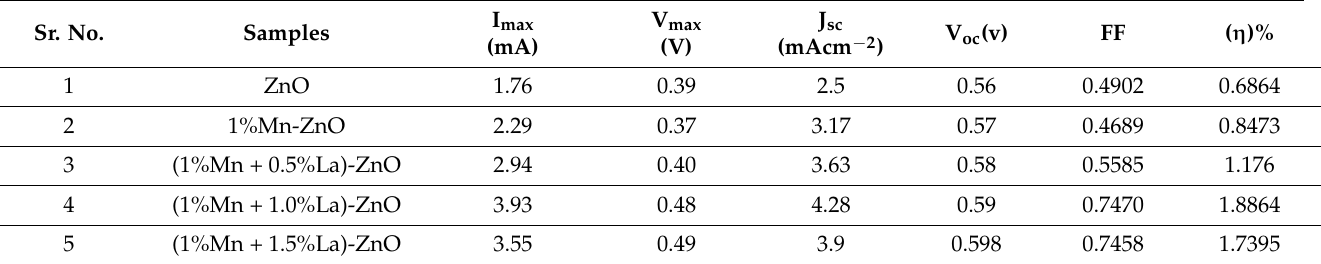
Figure 11. Current density–voltage curves for undoped and co-doped ZnO-based DSSCs. Table 3. DSSC parameter